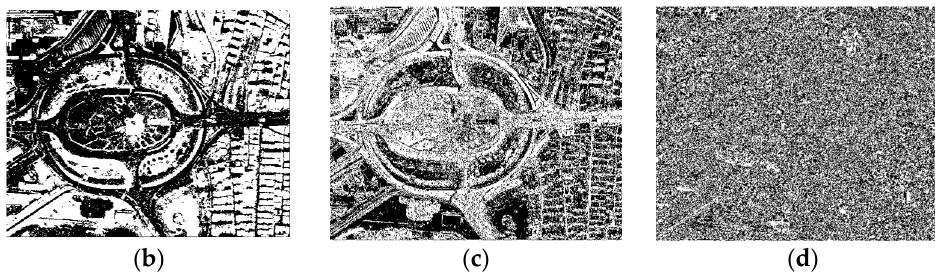
Figure 8. Segmentation results of IKONOS satellite remote sensing image 1: ( a ) original remote sensing image; ( b ) TPSCA–PCNN segmentation result; ( c ) PCNN segmentation result; ( d ) ELM segmentation result.